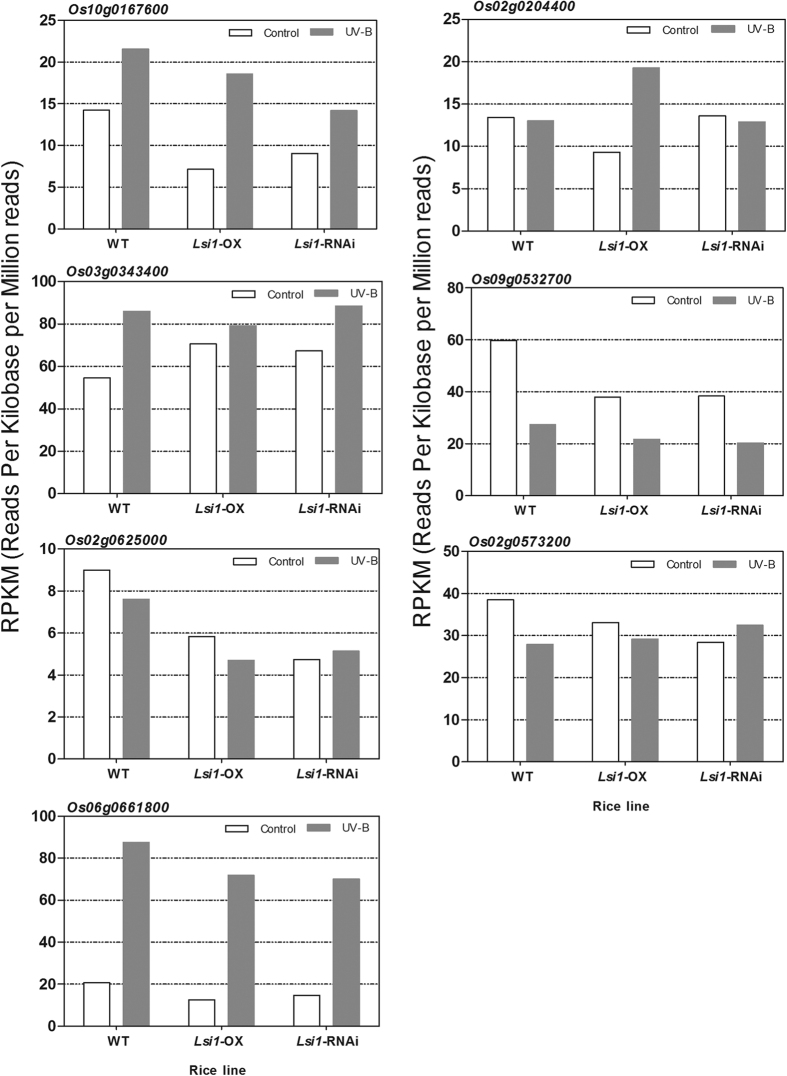
Transcriptional abundance of seven genes encoding photolyase or the photoreceptor in the UVB-treated Lsi1-OX, -RNAi, and WT lines of Lemont and the control groups.The transcriptional abundance of the seven genes was calculated as the reads per kilobase per million reads (RPKM), which is a method of quantifying gene expression from RNA sequencing data by normalizing the total read length and the number of sequencing reads. The RNA sequencing data were generated from the mRNA of the UVB-treated Lsi1-OX, -RNAi, and WT lines, respectively, and the control groups. The full RNA sequencing data are not shown here.